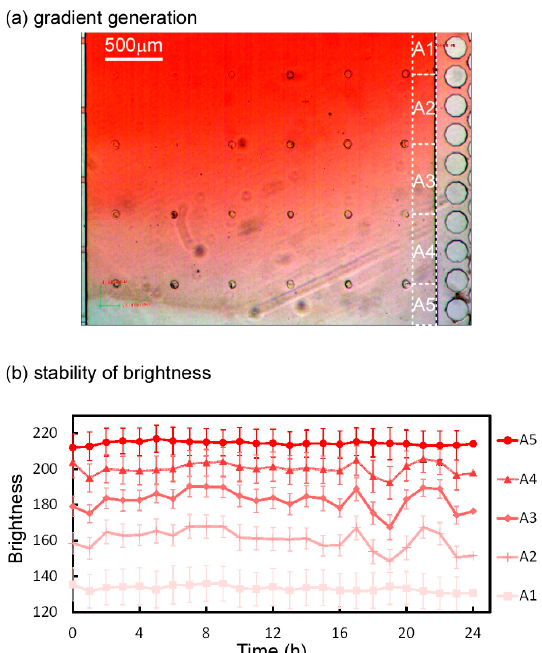
Figure 10. Stability of the brightness of the solution in a united cell culture microchamber. ( a ) Concentration gradation of the red-dyed solution in the cell culture microchamber; ( b ) Stability of the brightness in subsections A1–A5. Standard deviations of the brightness in all subsections were less than 5.7.